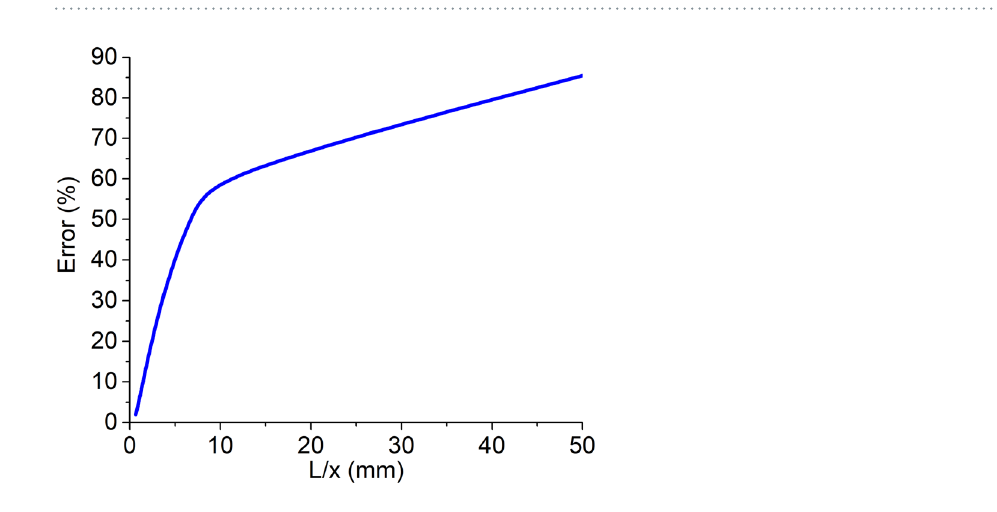
Figure 3. The dependence of n 2 measurement error on the value of the L/x